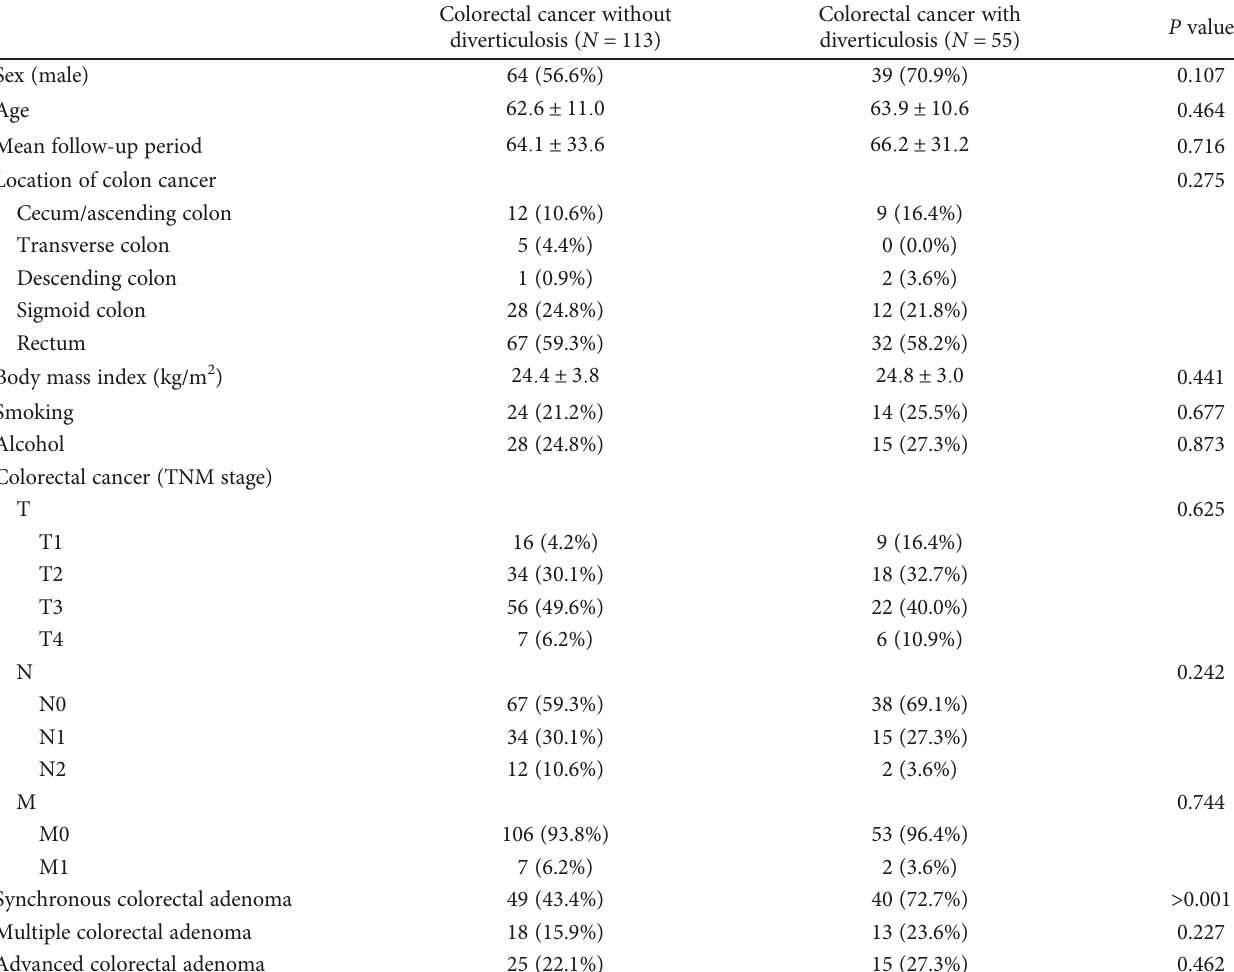
Table 1: Characteristics of patients with colorectal cancer according to the presence of diverticular disease.